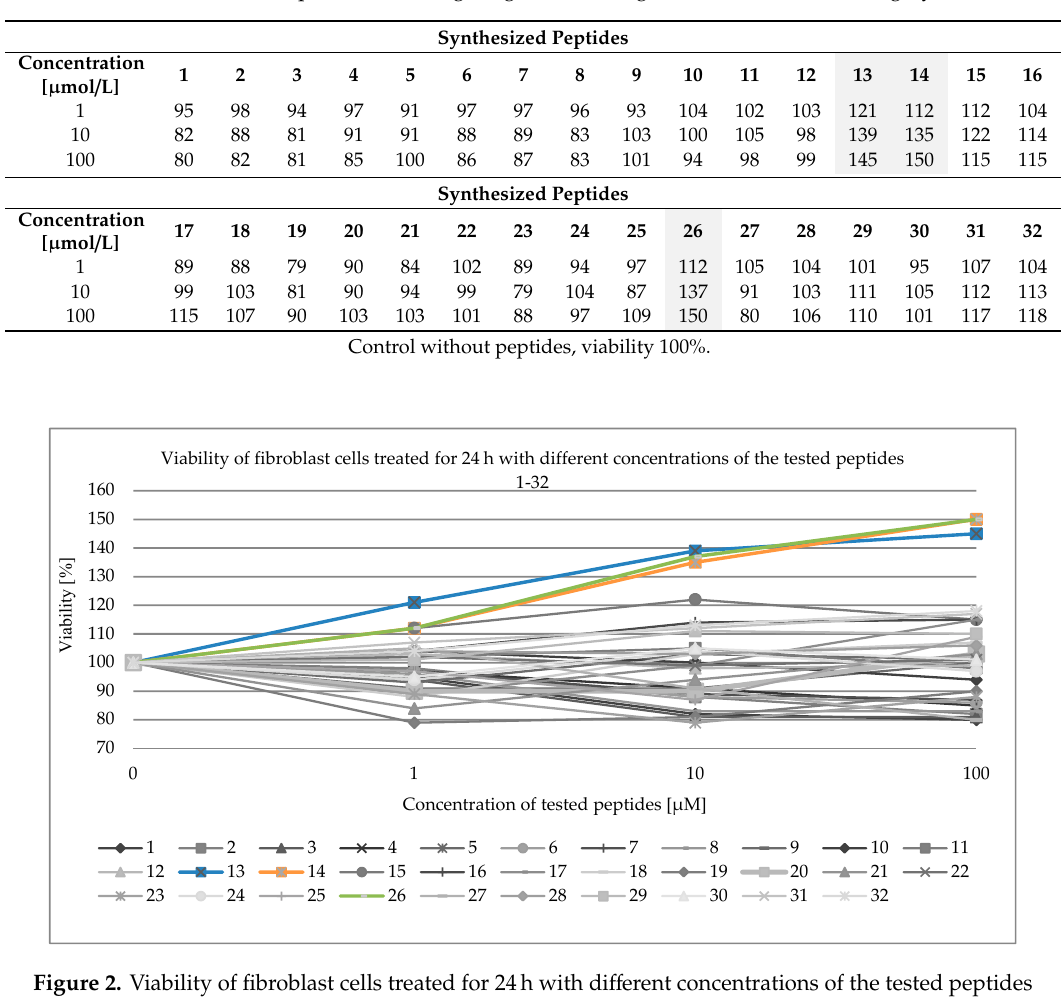
Table 3). Peptides H-Lys-Thr-Thr-Arg-Ser-NH 2 ( 13 , blue line, Figure 2), Ac-Lys-Thr-Thr-Arg- Ser- NH 2 ( 14 , orange line, Figure 2), and Ac-Arg-Thr-Thr-Lys-Ser-OH ( 26 , green line, Figure 2) exhibited cell growth effects. Table 3. Viability of fibroblast cells treated for 24 h with different concentrations of the tested peptides Table 3. Viability of fibroblast cells treated for 24h with di ff erent concentrations of the tested peptides 1–32 (% of Control ± 2). Peptides exhibiting a significant cell growth e ff ect are marked grey.